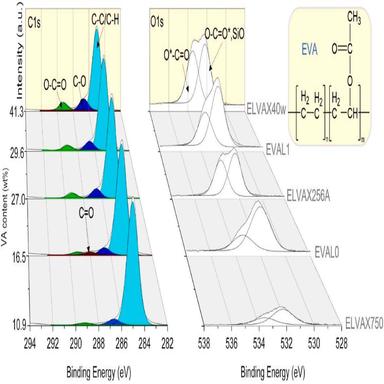
C1s and O1s HR spectra of the reference EVA grades with different VA content as determined by XPS. The chemical structure of EVA is shown in the inset.